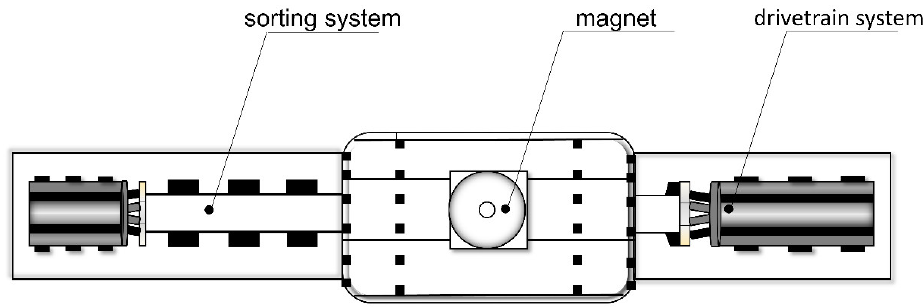
Figure 1. The 7.0T/100CGC low-temperature superconducting magnetic separator used in this study.